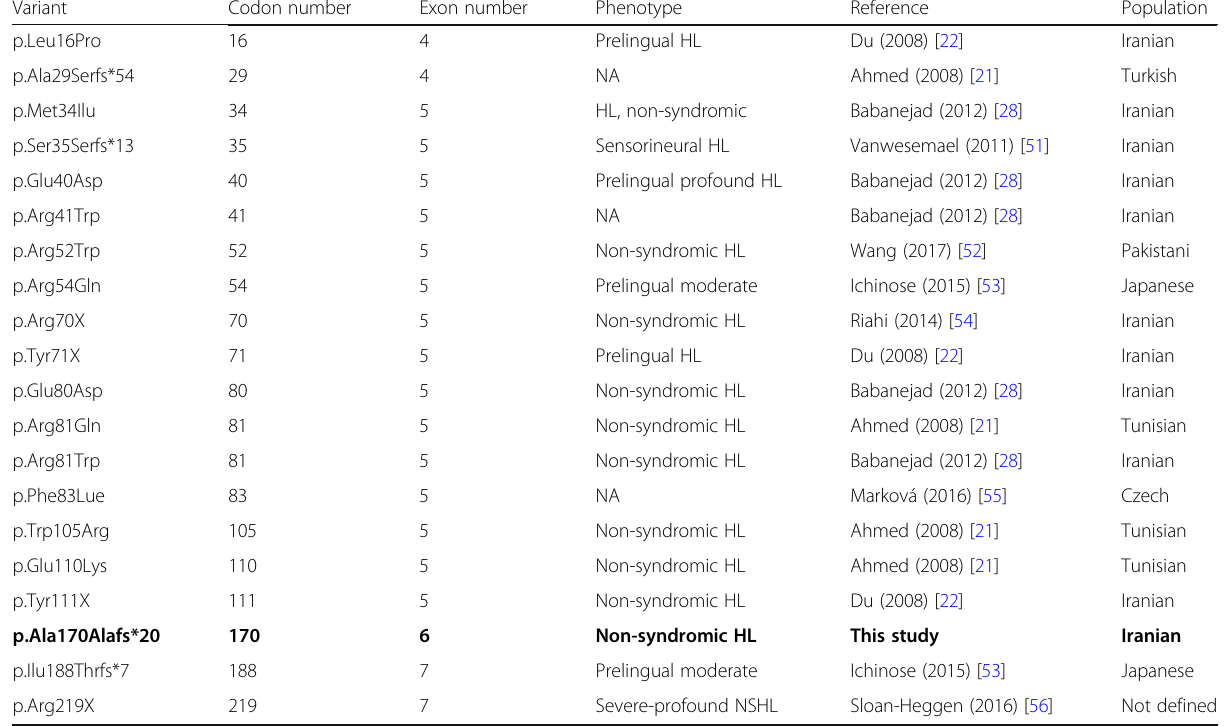
Table 2 Overview of all LRTOMT mutations so far identified